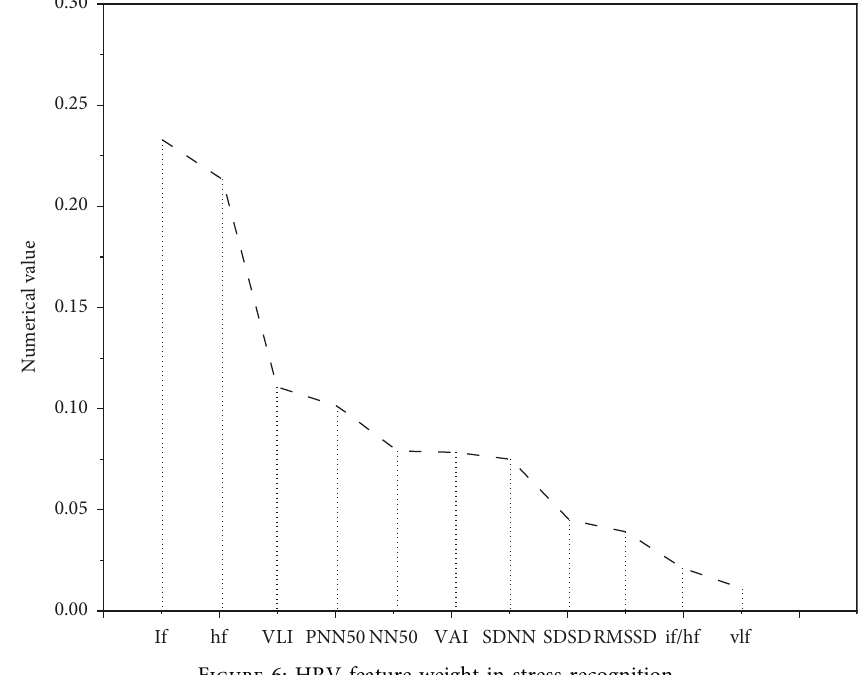
Figure 6: HRV feature weight in stress